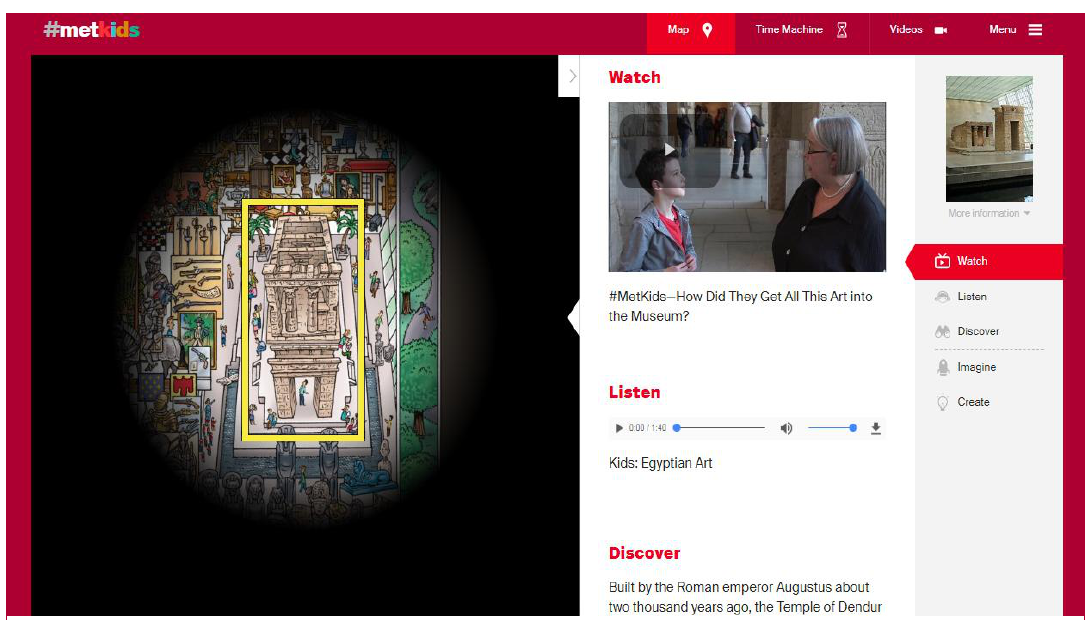
Figure 3. Metkids section, Metropolitan Museum of New York,